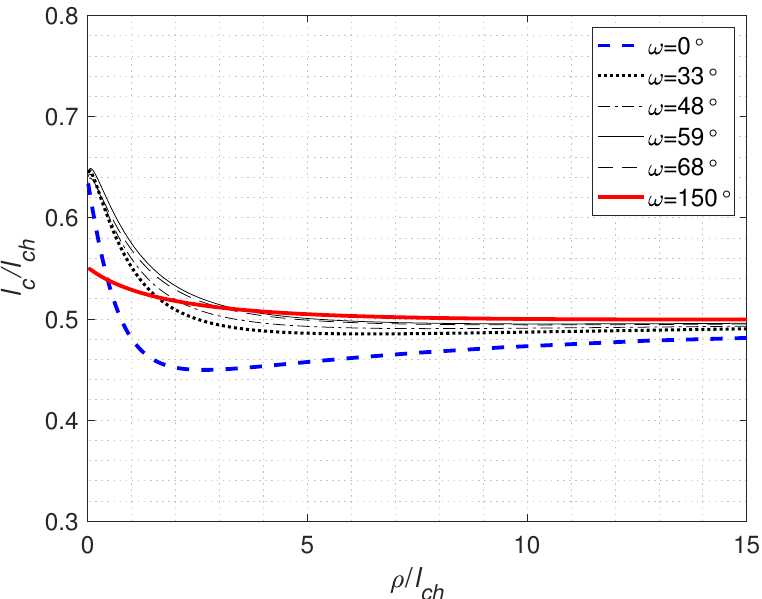
Figure 4. Critical crack advancement versus notch root radius normalized by Irwin’s length, l ch = ( K ) 2 ≈ 5.18 nm. Ic / σ u